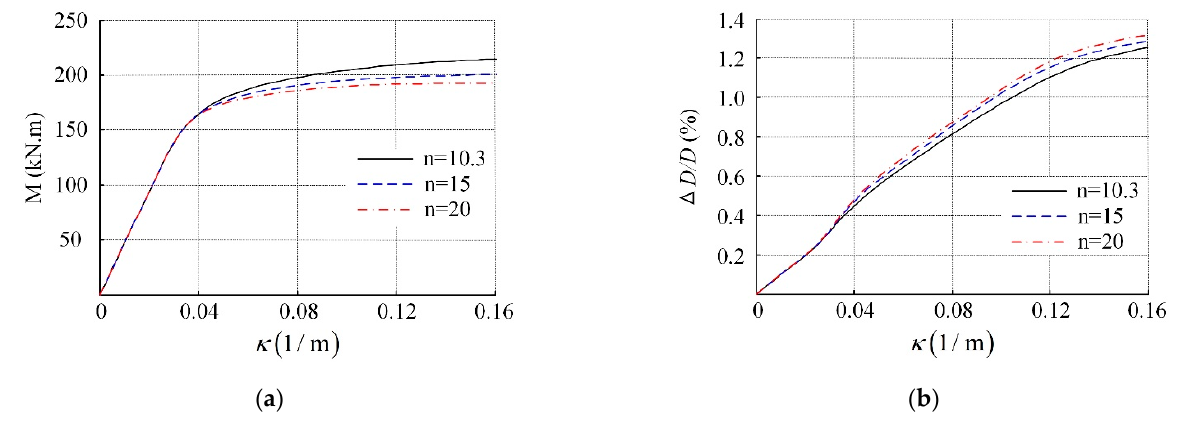
Figure 17. Effect of hardening index on ovalization and bending moment during pipe reeling: ( a ) variation of ovalization with curvature, ( b ) variation of bending moment with curvature.